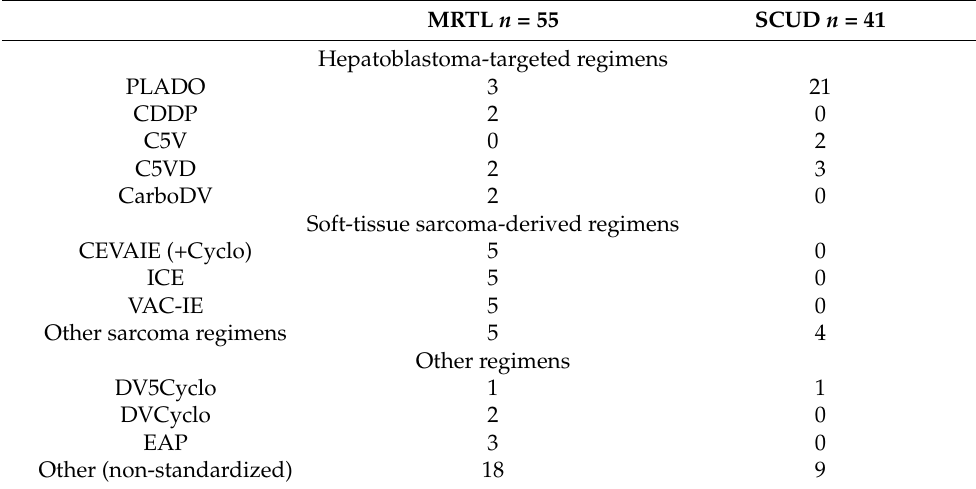
Table 3. Applied chemotherapy